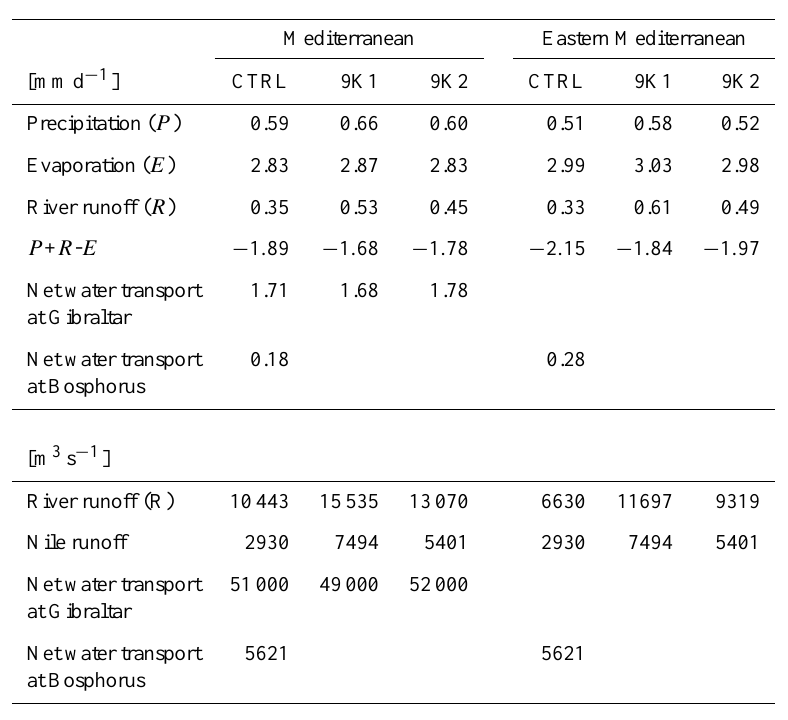
Table 1. Freshwater budget for the Mediterranean and the Eastern Mediterranean for CTRL, 9K1 and